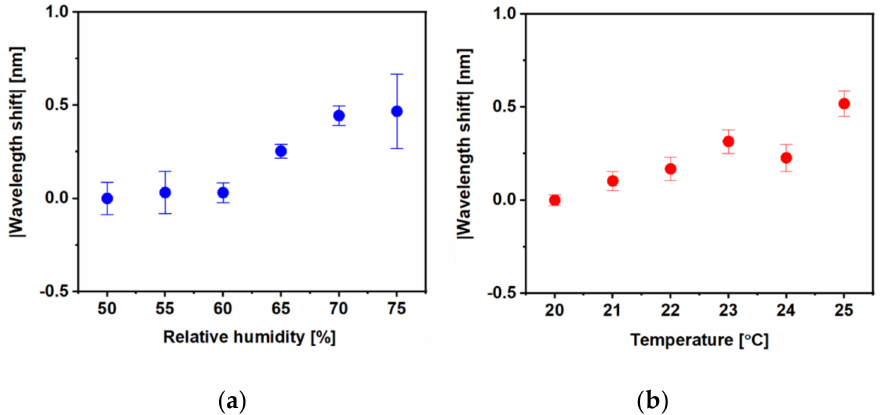
Figure 11. Cross-sensitivity of 120-cycle-coated MOF sensor for ( a ) humidity and ( b )